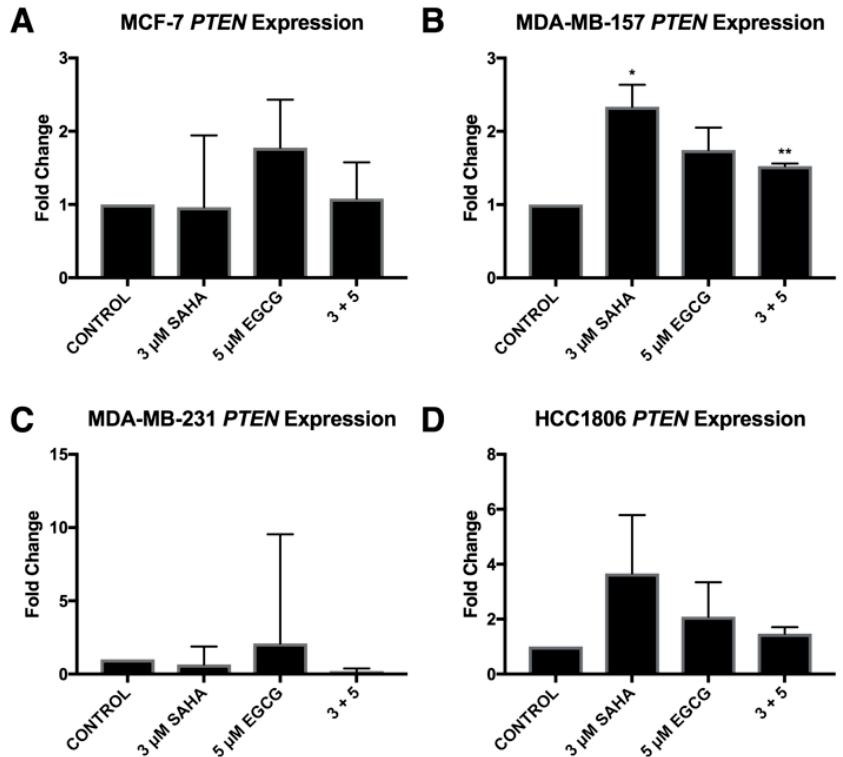
Figure 9. PTEN gene expression was only altered by SAHA and EGCG in the MDA-MB-157 cell line. ( A ) MCF-7 cells were treated with the indicated compounds for 72 h. qRT-PCR was completed using PTEN primers. ( B – D ) The same was done in the MDA-MB-157, MDA-MB-231, and the HCC1806 cell lines ( n = 3). Error bars represent standard error of the mean (SEM); * p < 0.05; ** p < 0.01.